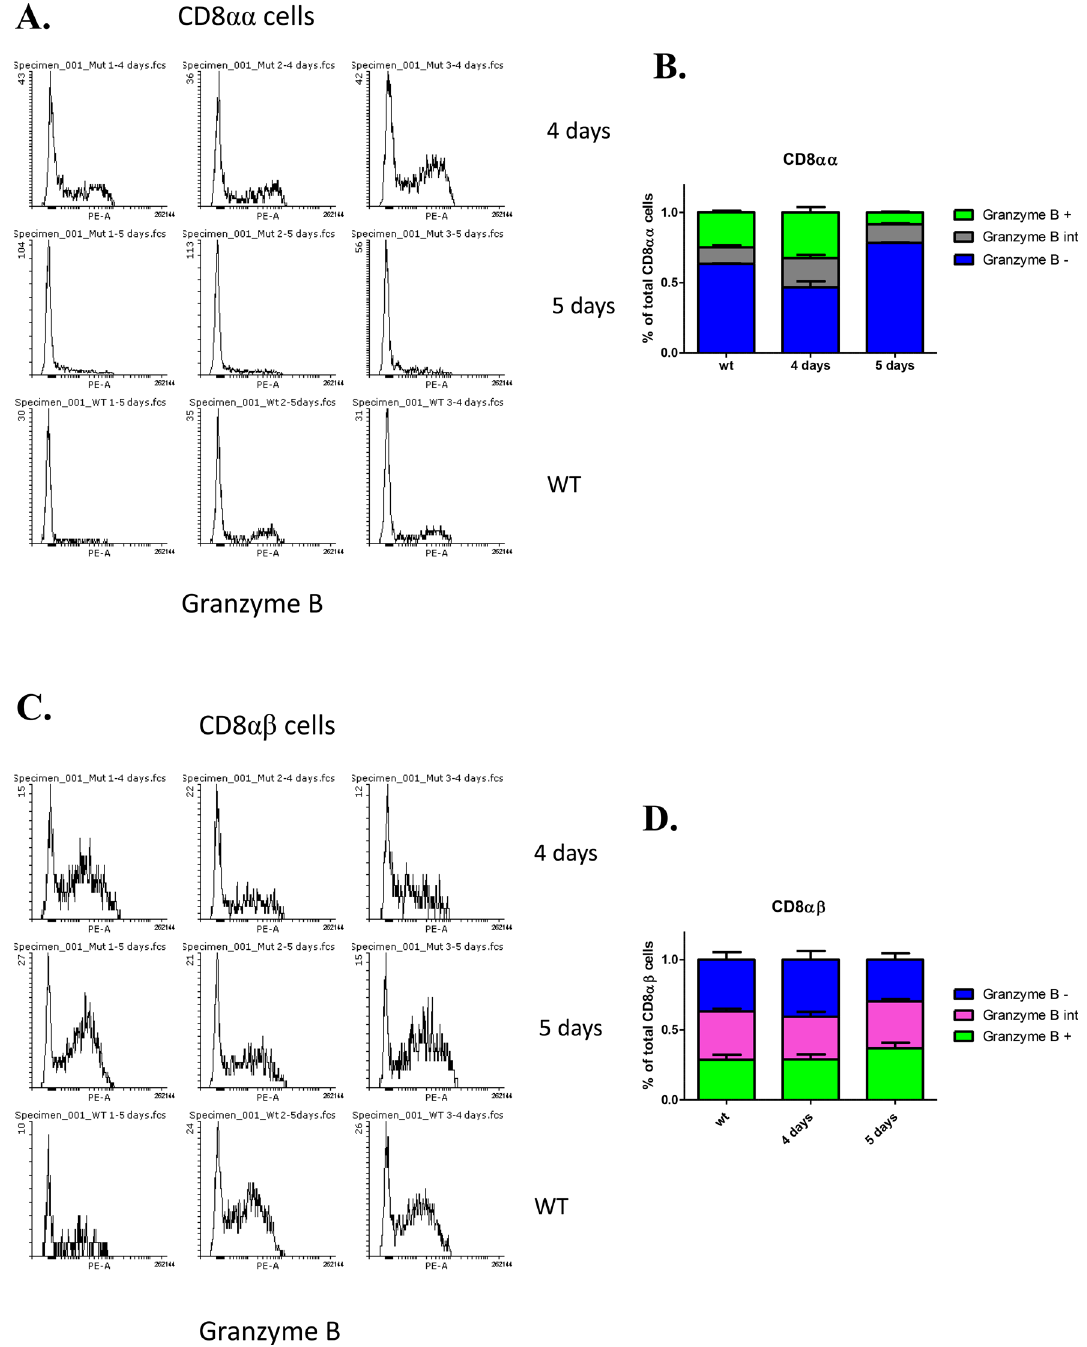
Figure 6. Cdx-dependent CD8αα degranulation. Intestinal cells were isolated 4 or 5 days post-tamoxifen treatment and CD45-positive cells assessed by flow cytometry for CD8α, CD8β and granzyme B. Data is representative of 3 independent biological